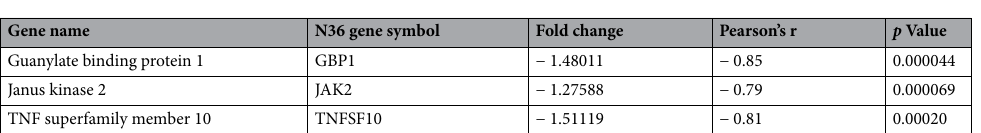
Table 5. Changes in PBMC expression associated with changes in FMD% following Lp299v supplementation. *Changes in differentially expressed genes were correlated with changes in brachial FMD% using Pearson’s r with significant correlations considered for P < 0.00035 following Bonferroni correction for multiple